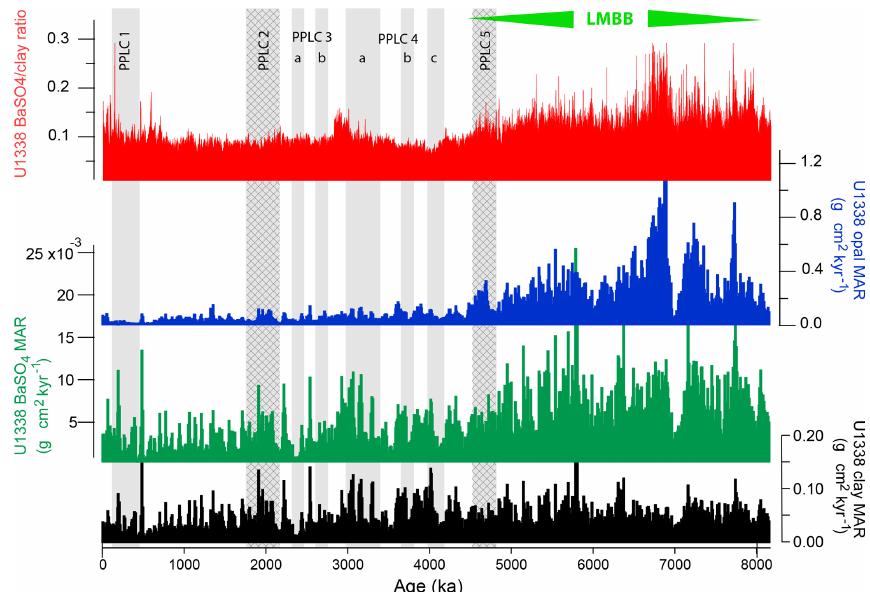
Figure 6. Site U1338 BaSO 4 / clay ratio and mass accumulation rates (MARs) of biogenic sediment components and clay. Gray bands mark PPLCs (Pliocene–Pleistocene Low CaCO 3 intervals) and hatched gray bands are productivity controlled. High bio-SiO 2 and BaSO 4 MAR prior to 4465 ka represents the LMBB interval at site U1338. Clay MAR is relatively constant over the 8 million years and is shown by the drop in BaSO 4 / clay ratio at that